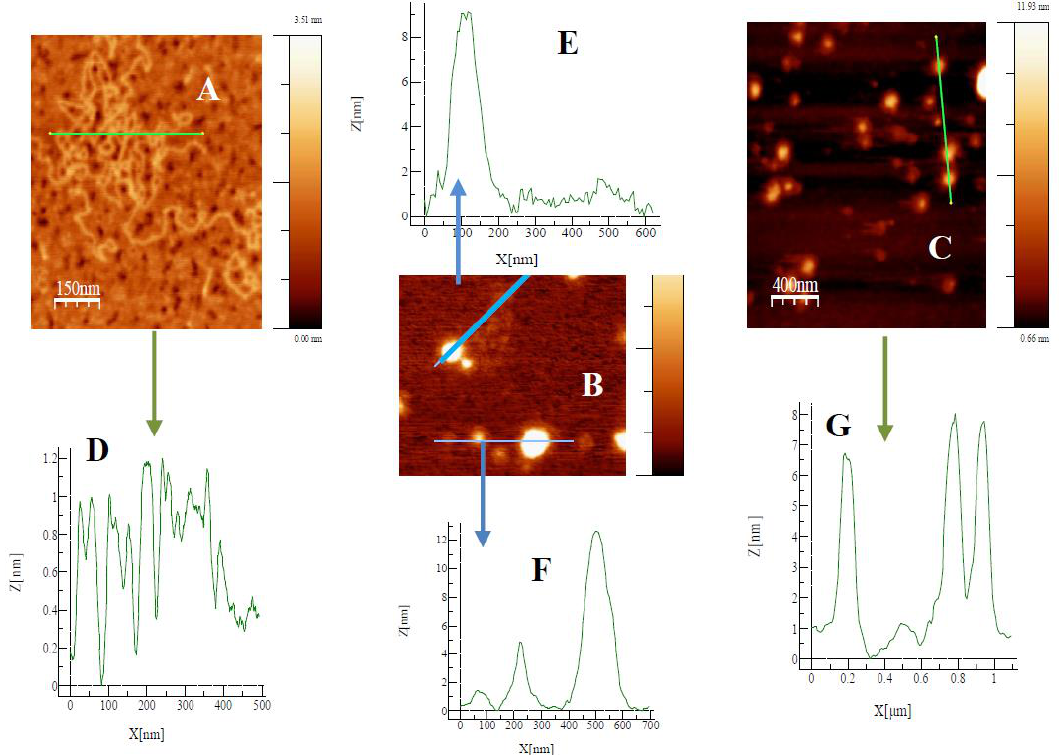
Figure 7. Topography AFM images for free DNA ( A ), and lipoplexes of RuC11C11 ( B , α = 0.2 L / D = 6) and RuC19C19 ( C , α = 0.2 L / D = 11). Profile of free DNA and lipoplexes ( D – G ).